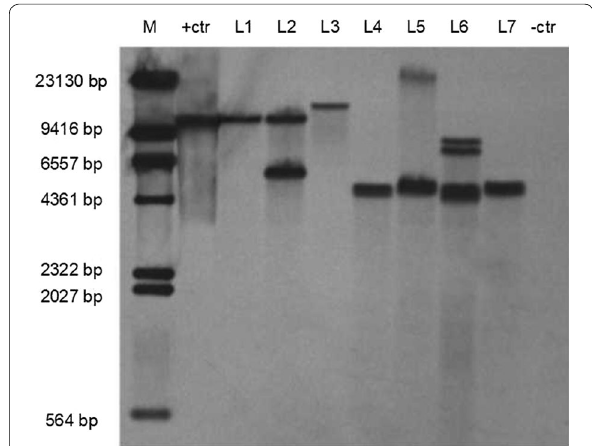
Fig. 3 Southern blot analysis of T 1 plants. M: DNA molecular markers; ctr: vector was used as the positive control; L1–L7 indicate genomic + DNA of T 1 plants from T 0 line No. 3, No. 5, No. 7, No. 12, No. 14, No. 16, No. 17; -ctr: genomic DNA sampled from non-transformed soybean plants was used as the negative control